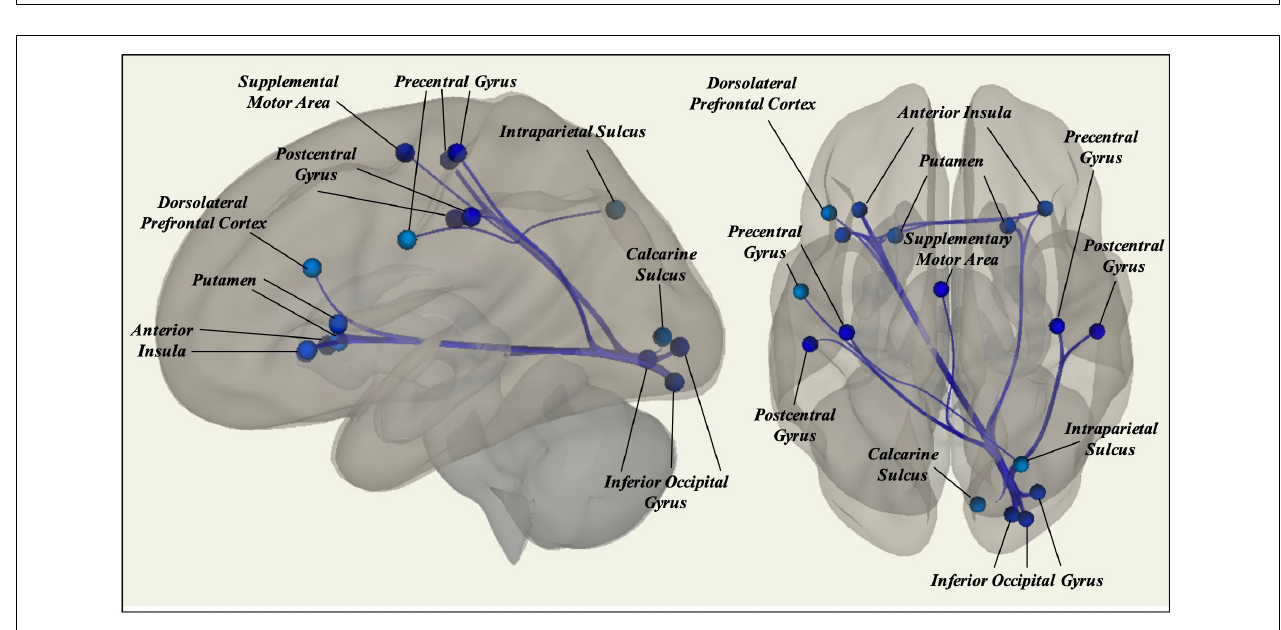
FIGURE 1 | Scatterplot of the relationship between Age and Framewise Displacement in the current sample.